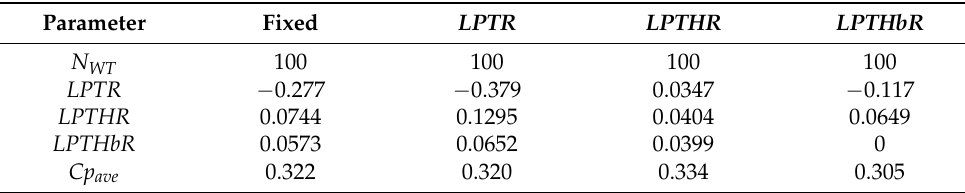
Figure 3. Variation of the rocess parameter with time, (square): fixed; (circle): LPTR ; (diamond): LPTHR ; (triangle): LPTHbR . Table 1. Results of the optimal